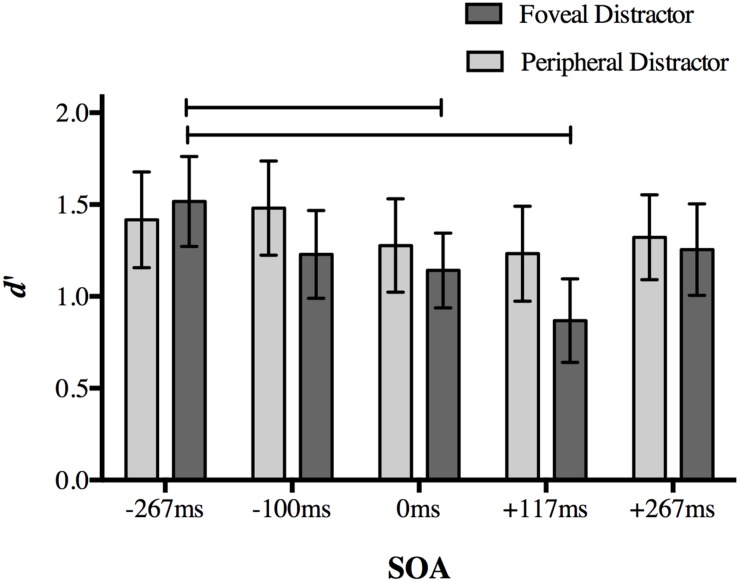
The effect of distractor location on peripheral target discrimination in Experiment 2. A foveal distractor appearing 117 ms after target onset or simultaneously with the targets disrupted discrimination accuracy more than a distractor presented at -267 ms SOA, replicating the main finding in Experiment 1. The timing of the distractor did not have an effect on discrimination accuracy when it was presented in the periphery. Lines indicate statistically significant differences between means after Bonferroni correction for 20 comparisons (p < 0.0025). Error bars represent 95% confidence intervals.